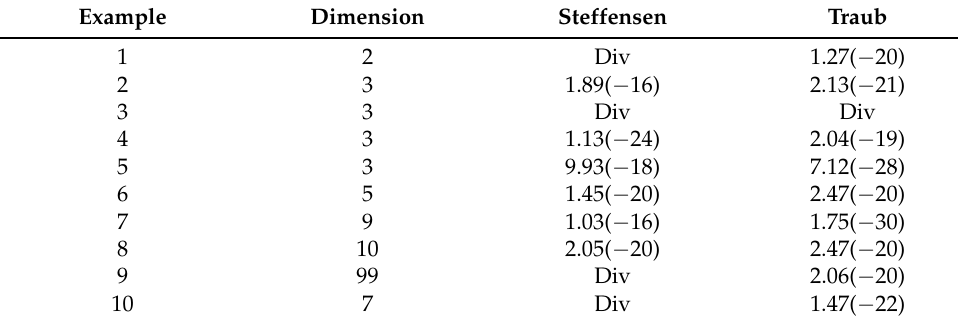
Table 3. Accuracy of methods for each